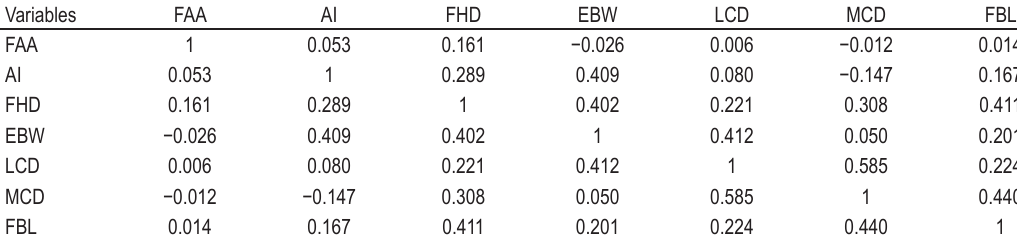
TABLE 5. Correlation matrix for female samples